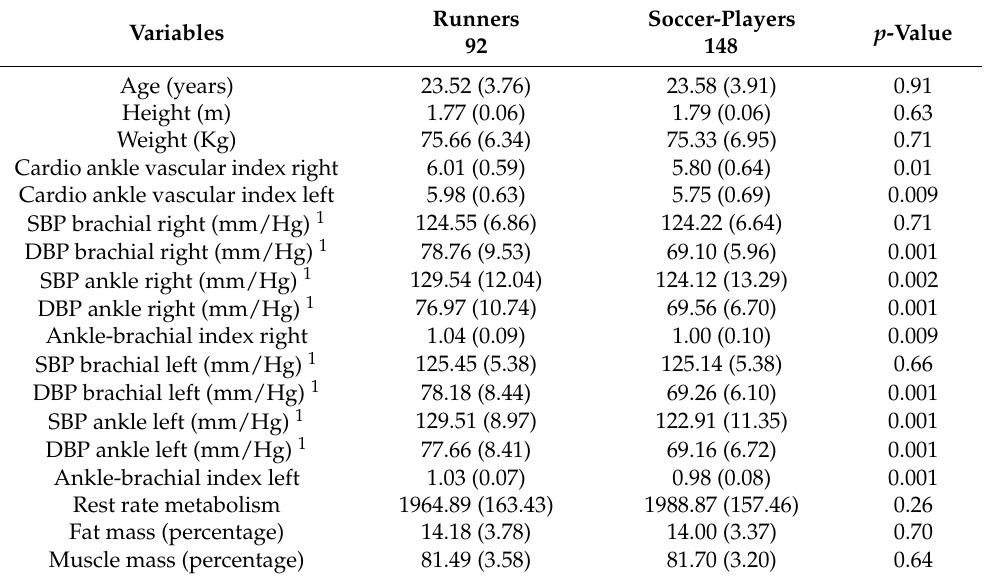
Table 1. Systematic differences between runners and soccer players in body composition, blood pressure, and in arterial